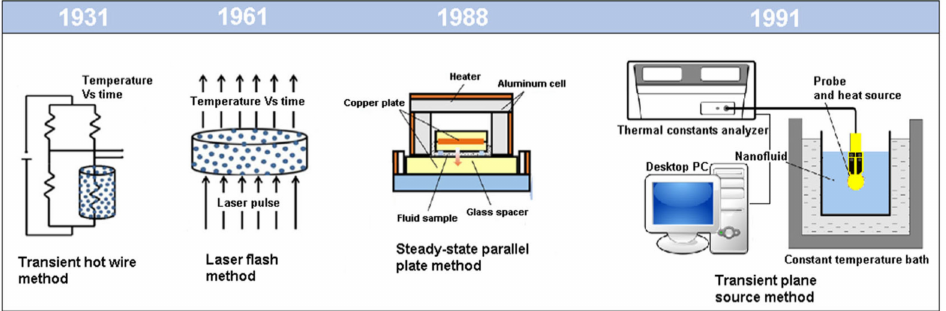
Figure 2. Schematic diagram of steady and transient state methods to measure the thermal conduc- tivity of nanofluids (NFs) (Adapted from